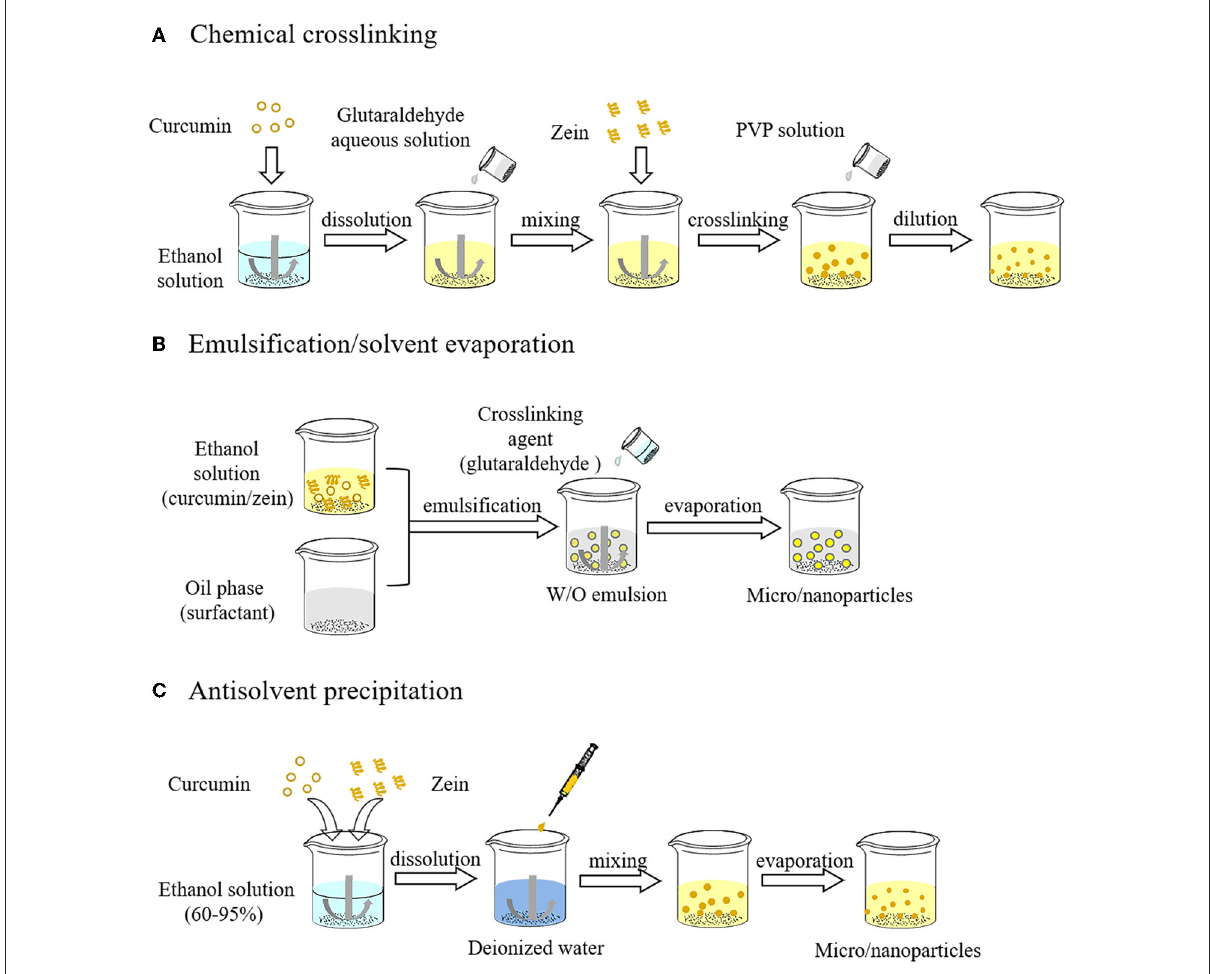
FIGURE3 Preparation process of zein particles by chemical crosslinking (A) , emulsification/solvent evaporation (B) and antisolvent precipitation (C)